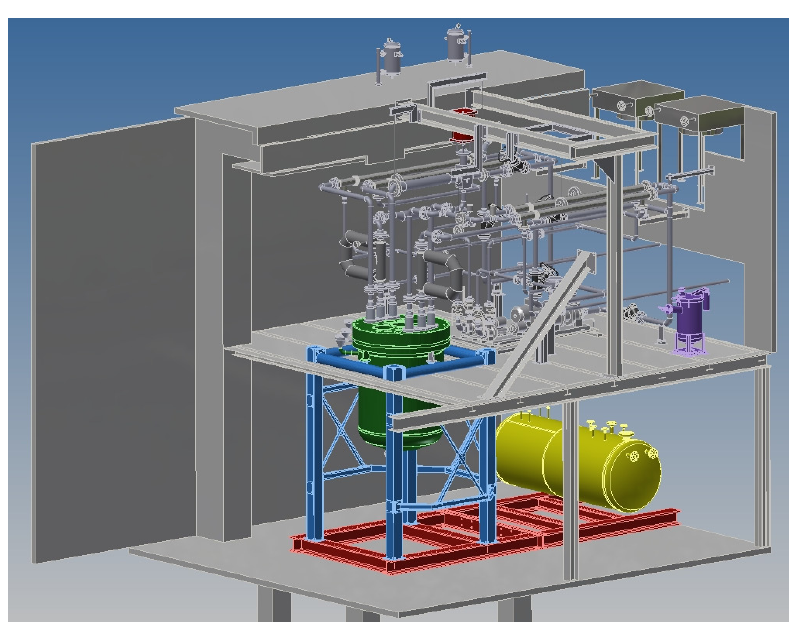
Fig. 7. – E-SCAPE facility representing a 1/6 Mock-up of MYRRHA reactor with all its in-vessel internals and electric heating of 15 kW for the decay heat simulation of the